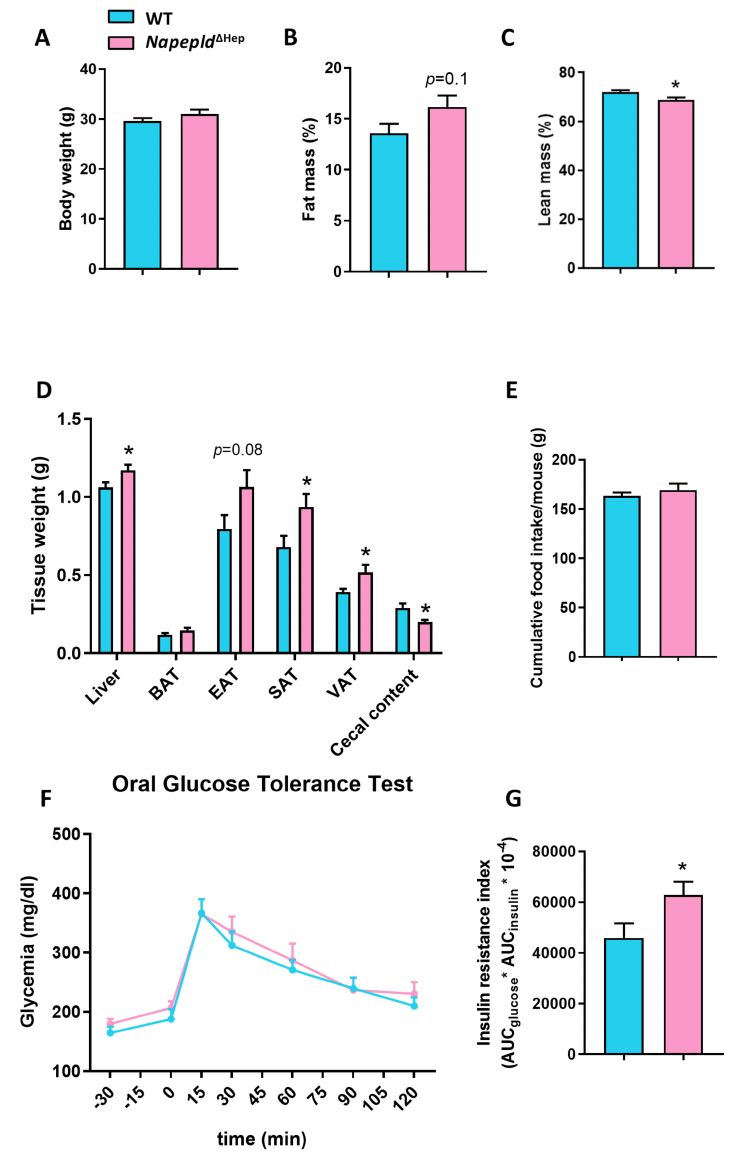
Figure 2. Napepld ∆ Hep mice develop a high-fat diet-like phenotype upon normal diet. ( A ) Body weight (g), ( B ) fat mass (%) and ( C ) lean mass (%) after a 7 weeks period on normal diet. ( D ) Weight (g) of di ff erent tissues: liver, brown adipose tissue (BAT), epididymal adipose tissue (EAT), subcutaneous adipose tissue (SAT), visceral adipose tissue (VAT) and cecal content. ( E ) Cumulative food intake per mouse (g) after a 7 weeks period. ( F ) Plasma glucose profile (mg / dl) measured between 30 min before and 120 min after oral glucose loading ( G ) Insulin resistance index determined by multiplying the area under the curve (AUC) of blood glucose by the AUC of insulin. Blue: WT ND mice. Pink: Napepld ∆ Hep ND mice ( n = 8–10). Data are presented as the mean ± s.e.m. *and ** indicate a significant di ff